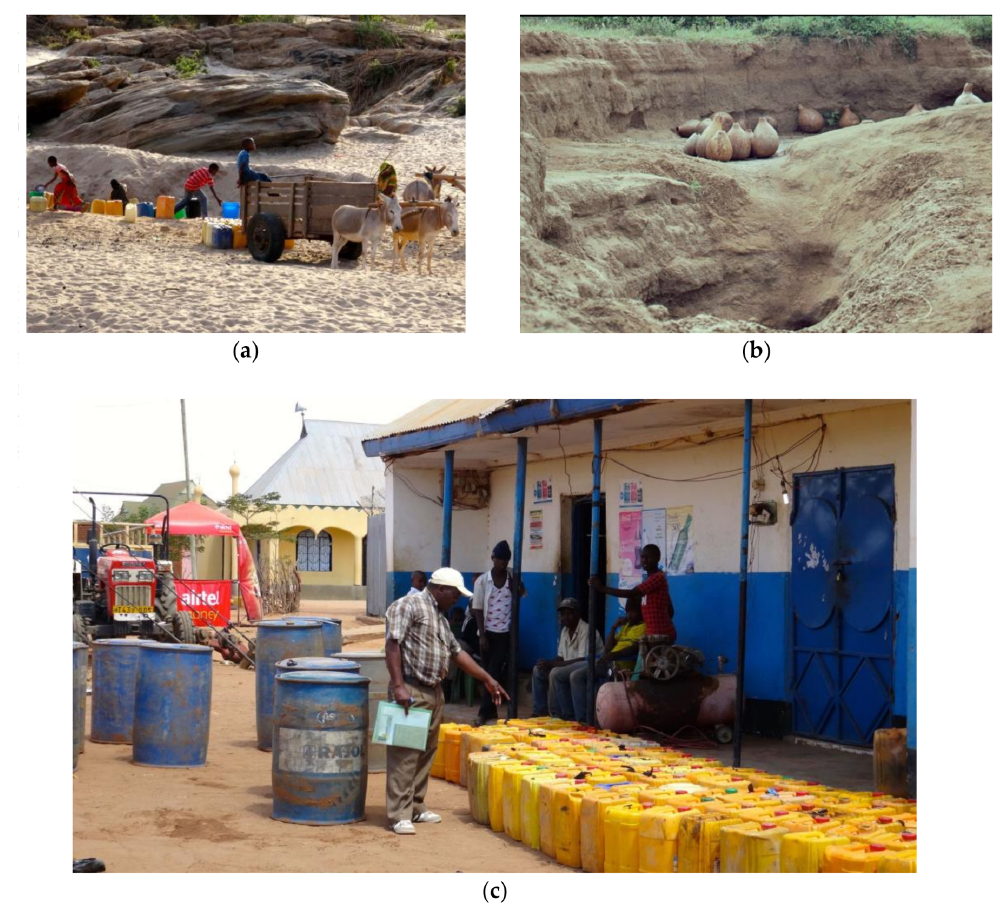
Figure 3. ( a ) Drawing water from shallow wells in dry river bed. ( b ) Gourds lined up to be filled with water from shallow wells dug in a dry river bed, 1991. ( c ) Household water on sale at Goima village centre,